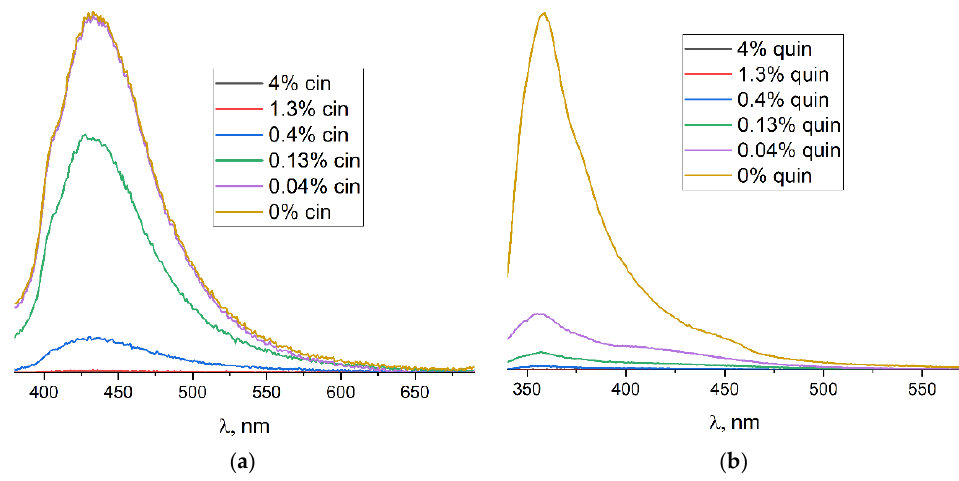
Figure 5. Emission spectra for DMF suspension of 3 with cinnamaldehyde at λ ex = 360 nm ( a ) and with quinoline at λ ex = 320 nm ( b ) at different concentrations.